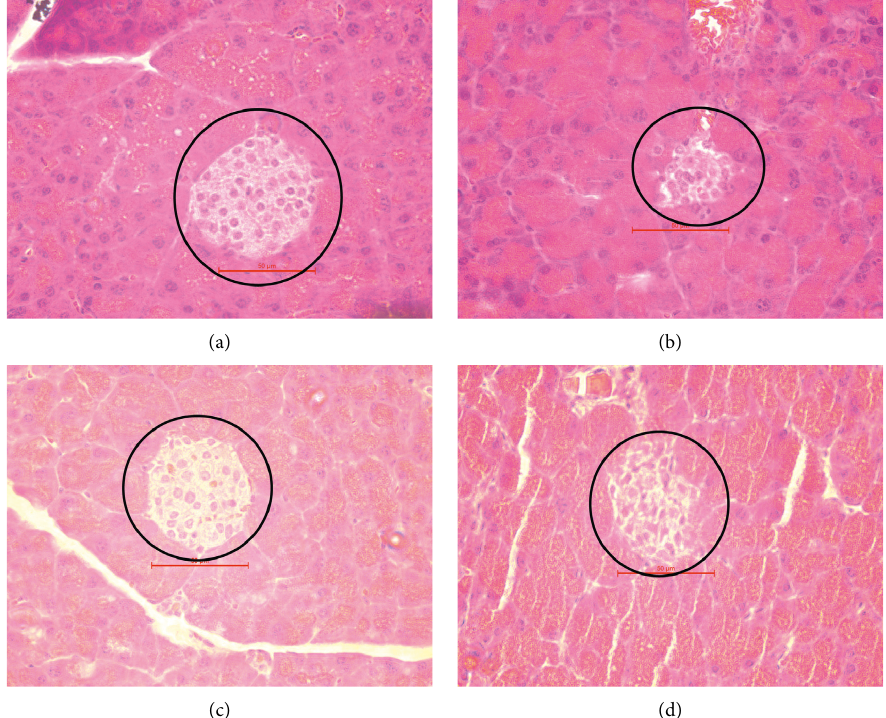
Figure 4: Pathological tissue sections from the pancreas of normal and type 2 diabetic mouses. (a) Nondiabetic group. (b) Diabetes model group. (c) Metformin group. (d) SDF